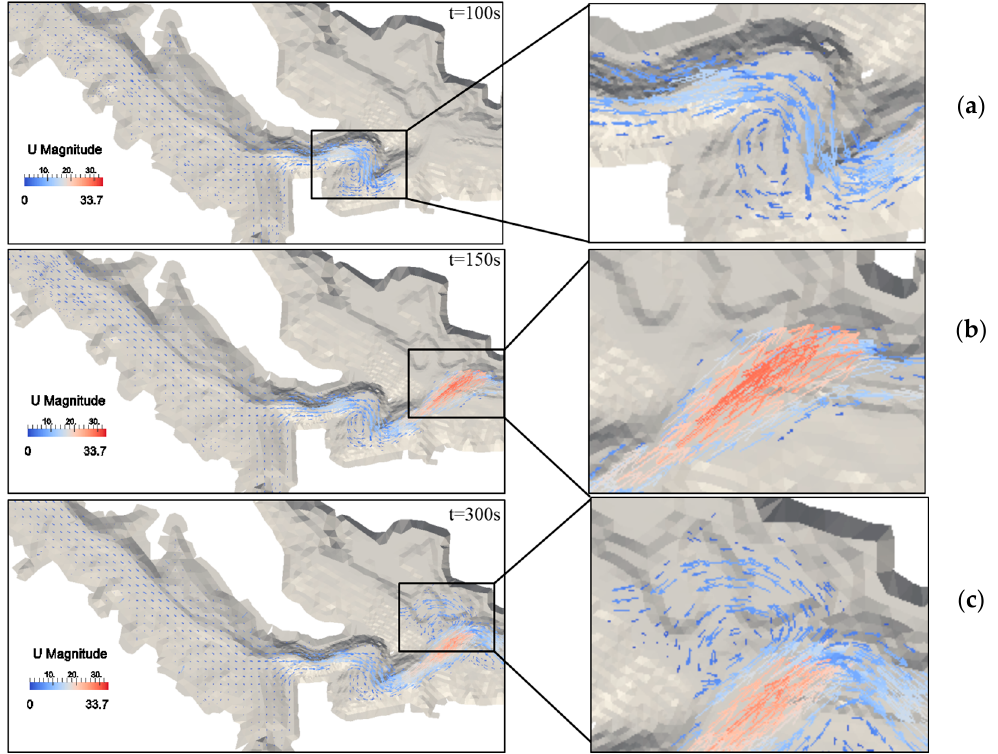
Figure 10. Velocity fields in the proximity of point P2 at: 100 s ( a ); 150 s ( b ); and 300 s ( c ) after the dam collapse.